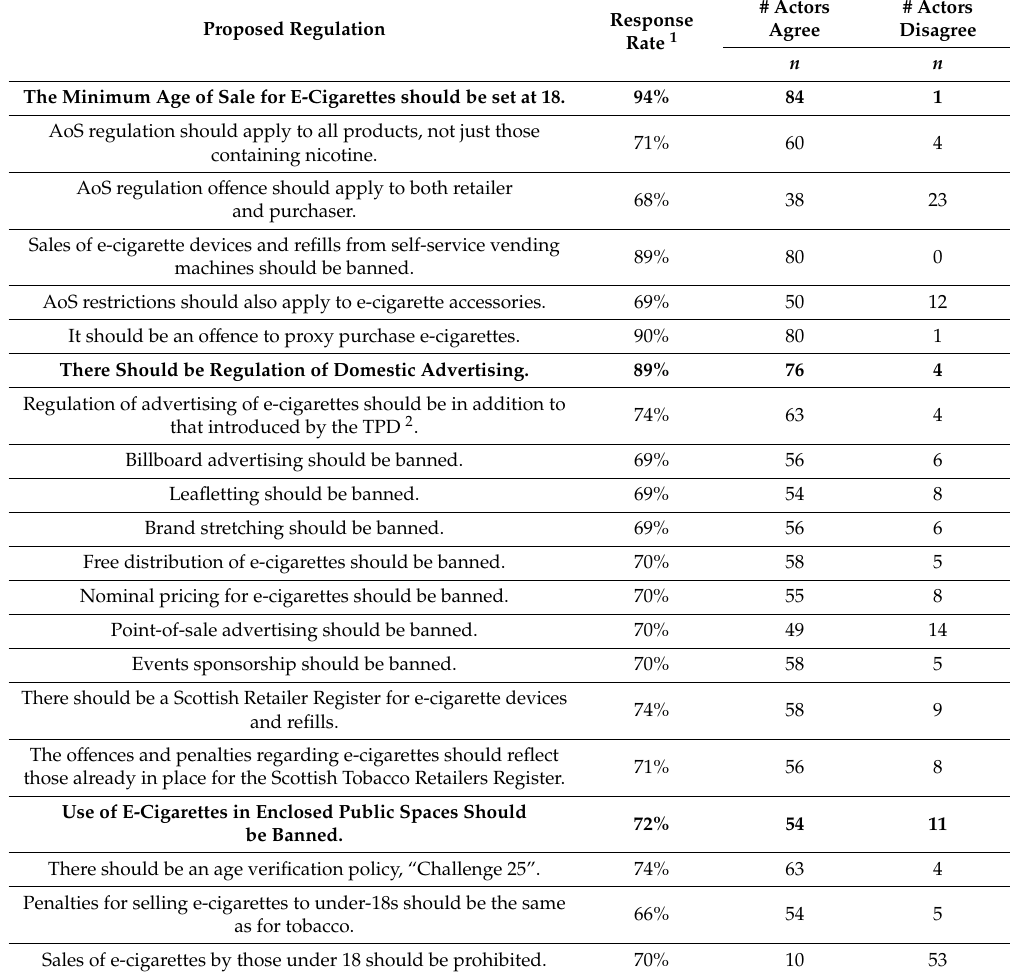
Table 4. Overall agreement and disagreement with elements of e-cigarette regulation that were suggested in the consultation by health-focused actors. Data extracted from consultation responses. Proposed Regulation Response Rate